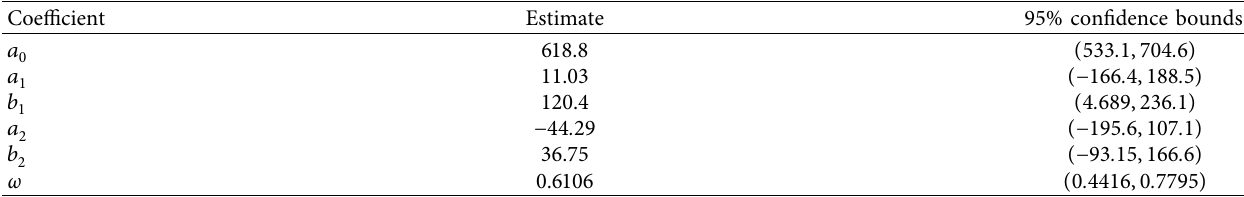
Figure 7: Time series of Limnothrissa miodon for varying fishing effort for model system (2) with E � 7625 (colour purple), E � 15250 (colour magenta), and E ∗ � 15394 (colour Table 1: Fourier coefficients from data fitting.